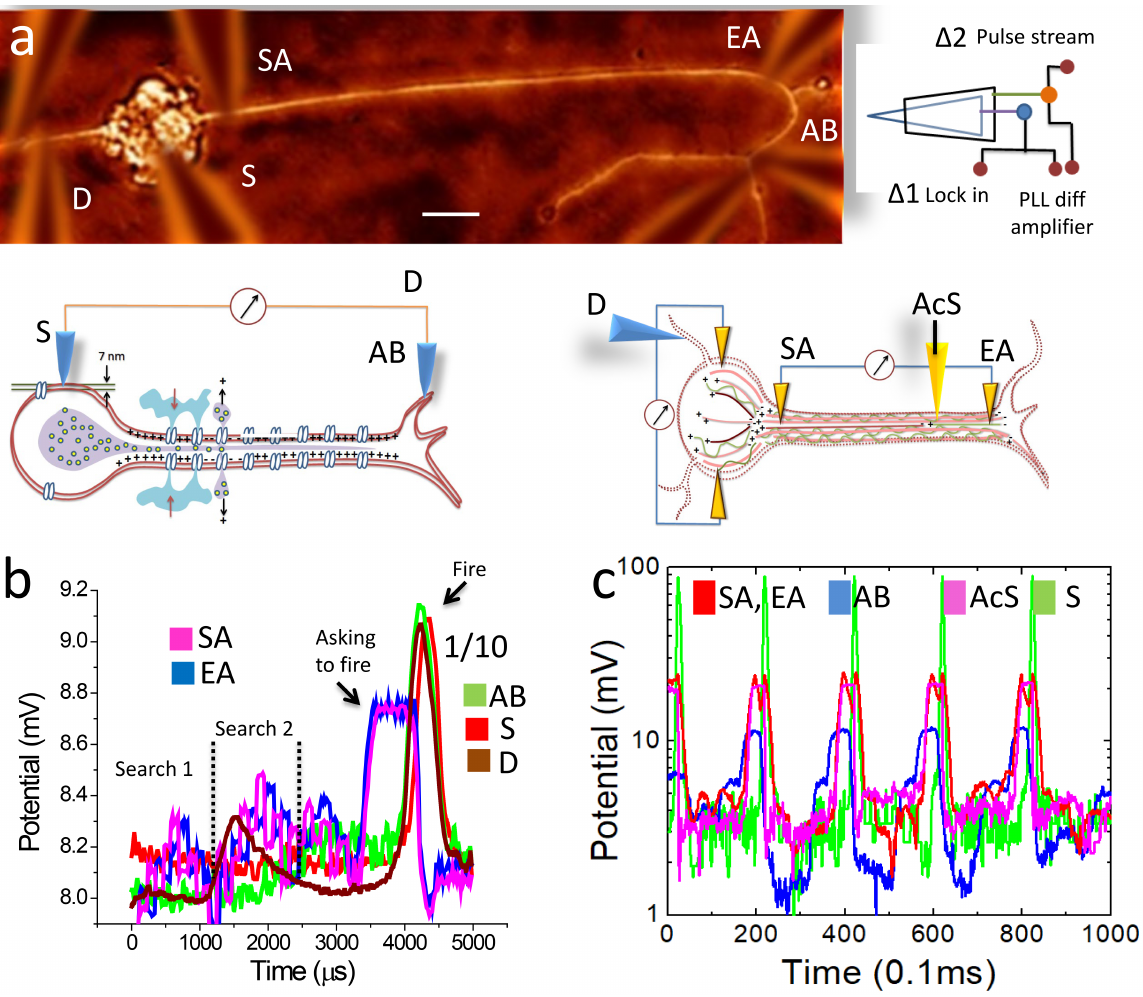
Fig. 3. Measuring natural oscillations deep inside a neuron during firing. (a) Five electrodes are connected to an 8-day old rat hippocampal neuron cultured from embryonic cells, S, Soma; D, Dendrimer; SA, Start of the axon; AIS, Axon Initial Segment; EA, End of axon; AB, Axonal branch. Bottom, a microscope image of a neuron, probes faded as the neuron is focused, scale bar is 50 µ m. S, D, AB make surface contact, EA, SA makes deep axon core contact. (b) Current recording of 5 ms that includes an ionic firing and current flow at all five probes. The potential (mV) for S, D, AB is reduced by 1/10 to compare all responses in a single time scale [23]. (c) The same plot as panel (b), but for consecutive pulses (total time 100 ms), the potential axis is in log scale, AcS, Actin-beta Spectrin